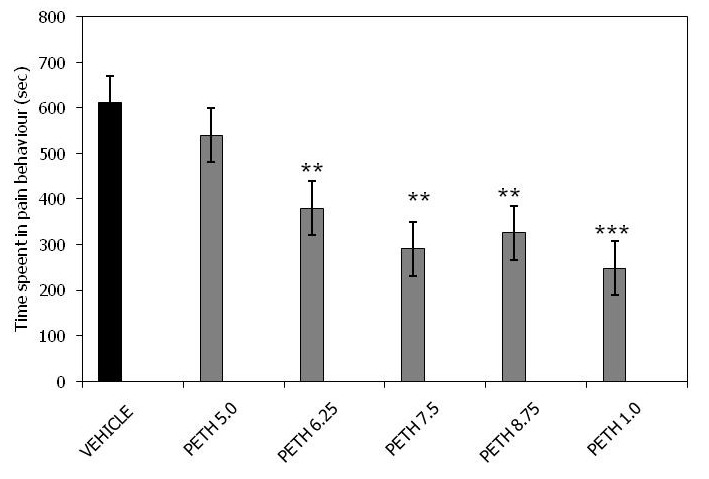
Pethidine late phase of formalin test. Each group represents the mean ± SEM of 10 animals. **p<0.01, ***p<0.001 when compared with the control value subsequent to ANOVA